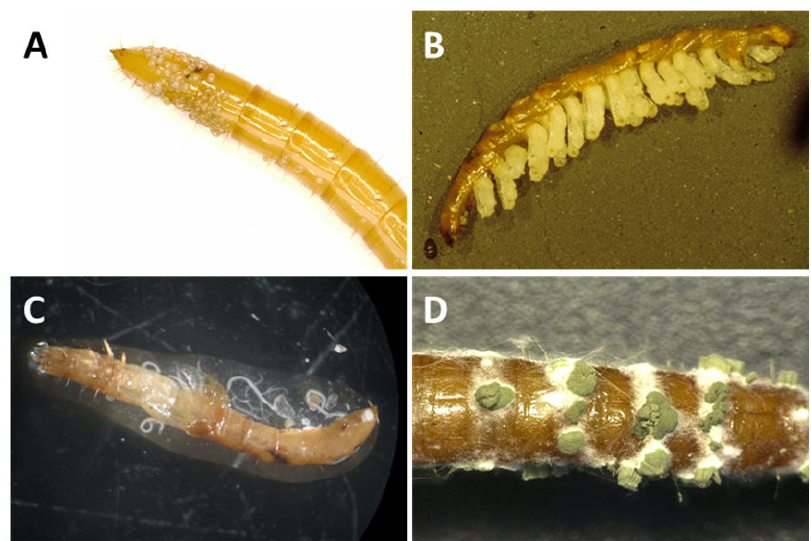
Figure 4. Illustrations of wireworm biocontrol agents. ( A ) Mite infestation of an Agriotes ustulatus wireworm; it is unclear if these mites are parasitic or phoretic, but heavy infestations appear to affect wireworms negatively; ( B ) Agriotes sp. wireworm with gregarious hymenopteran par- asitoid, most likely Paracodrus apterogynus ; ( C ) Agriotes sordidus infested by the nematode S. boemarei (strain FRA48, Lee etal. 2009) carrying the symbiotic bacterium Xenorhabdus kozodoii FR48; and ( D ) Agriotes lineatus wireworm with Metarrhizium brunneum infestation. Photographs A, B, D: JKI. Photograph C: